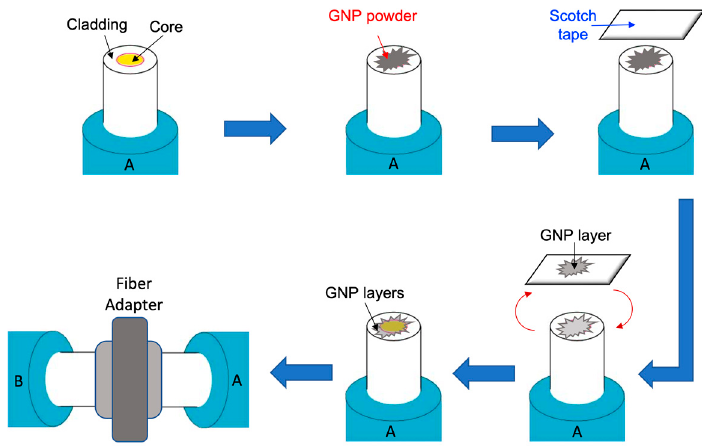
Figure 2. Fabrication of GNP-SA, A represents a FC/PC pigtail which the deposited GNP and B is another FC/PC pigtail for the mating process.